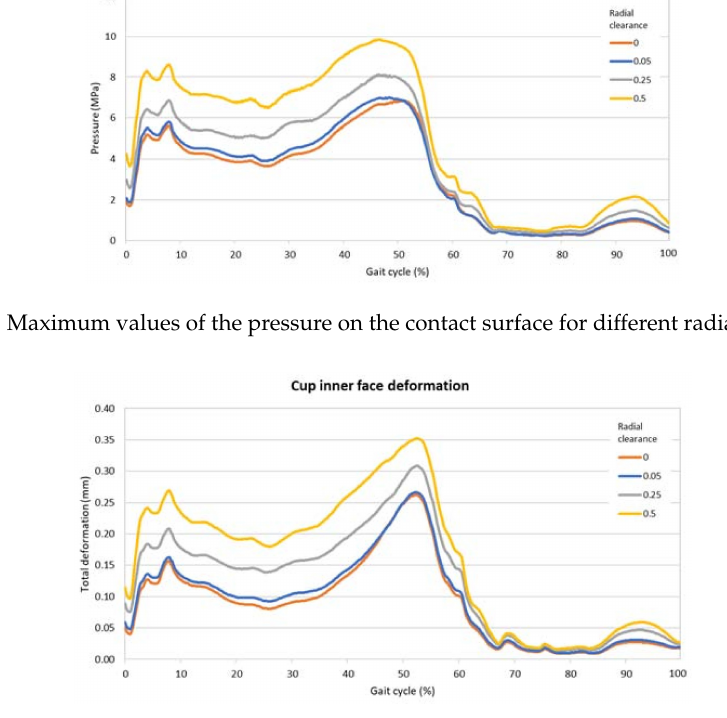
Figure 7. Maximum values of the deformation on the inner surface of the acetabular cup for different radial